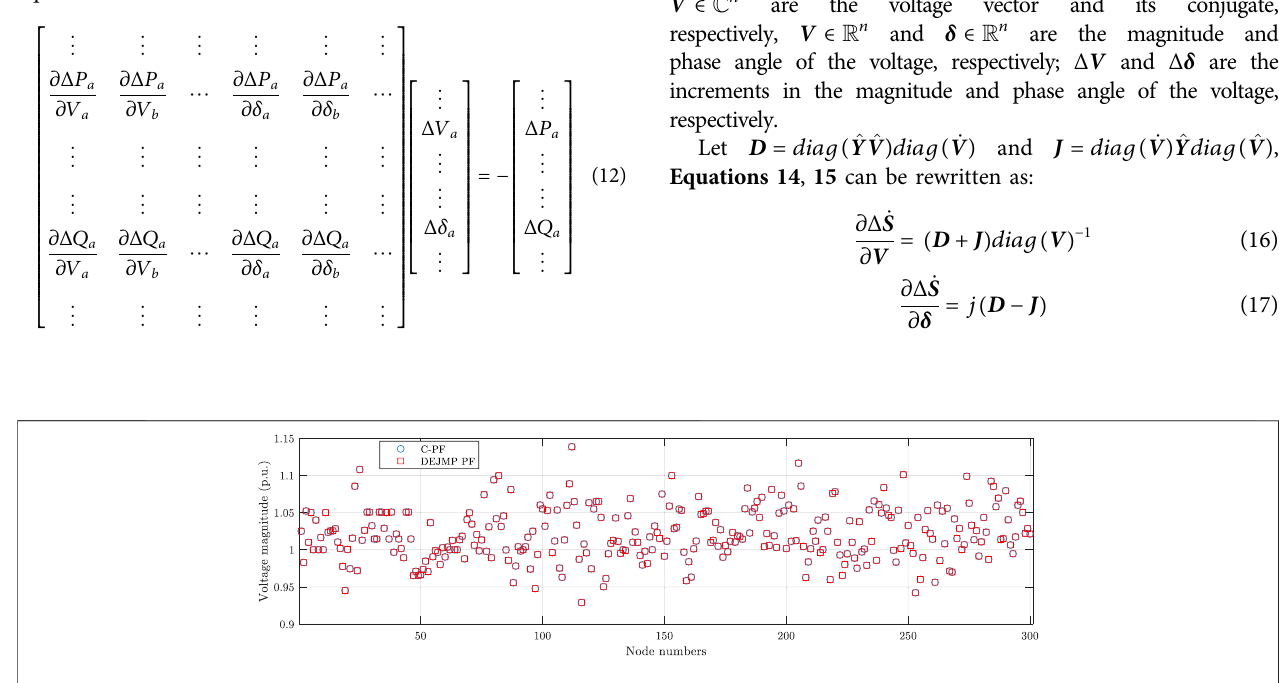
FIGURE 2 | the voltage magnitude obtained by DEJMP-based PF and C-PF on IEEE-300 bus systems.